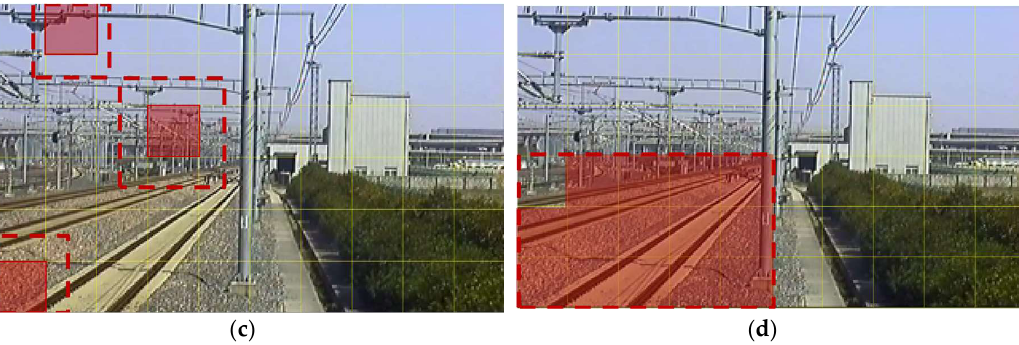
Figure 13. Rough scanning over the scene to find the potential track area. ( a ) Segmentation result of the whole railway scene images. ( b ) Different local areas. ( c ) Scanning the railway scene image roughly using proposed CNN. ( d ) Area in red dotted rectangle is the potential track area, which will reduce segmentation calculation by three-quarters. Table 3. Calculation time of the comparison experiments with different workflow to segment the railway scene.